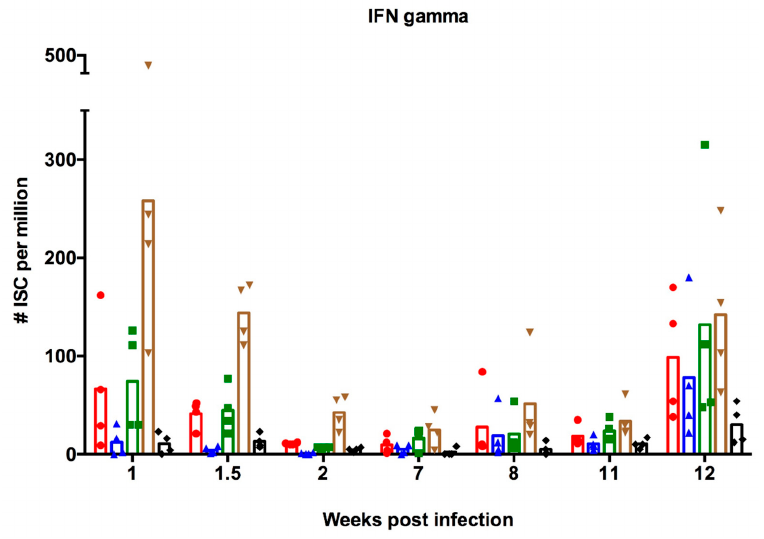
Figure 4. Numbers of virus-specific interferon-secreting cell (ISC) in PBMC for each individual pig after infection with NC95 and vaccination with PA10 followed by G08. Responses in PBMC were examined at weeks 1, 1.5 (day 11), 2, 7, 8, 11, and 12 after infection. The first and second vaccinations were performed at weeks 7 and 11, respectively. Symbols represent responses of four individual pigs which were examined at each time point. The mean numbers of ISC are shown by the bars. The different colors represent responses against the five different viruses ( NC95; PA10; G08; VIC75; HK14).